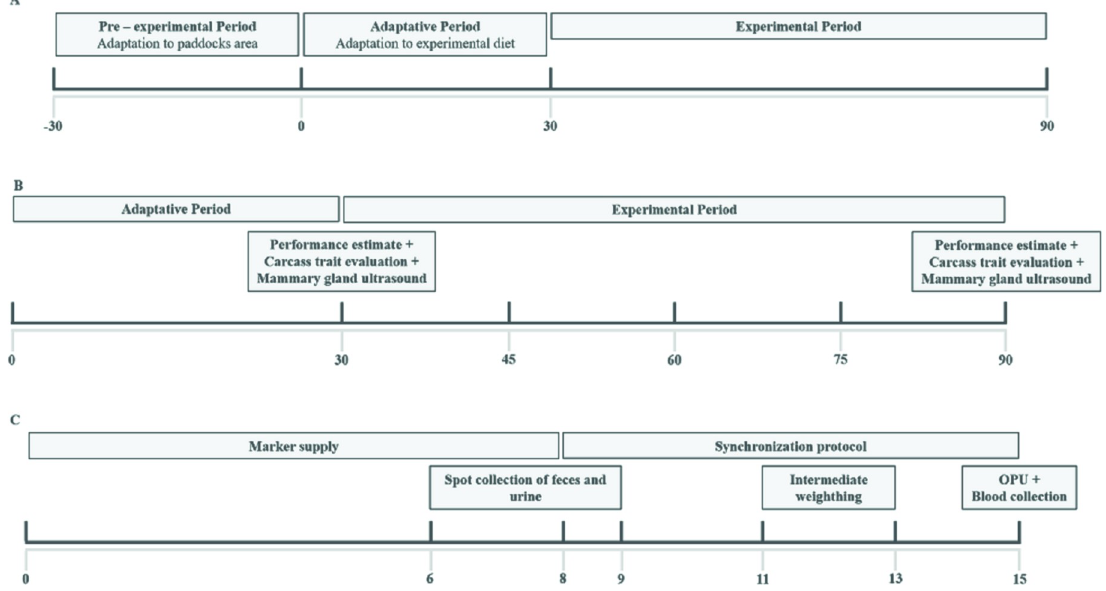
Fig 1. Experimental design of the different experimental phases. (A) Represents the division of the three moments of the experiment; (B) represents collections that started with the provision of experimental diets and the division of collection periods within the experimental period; (c) represents all procedures performed in each collection period (15